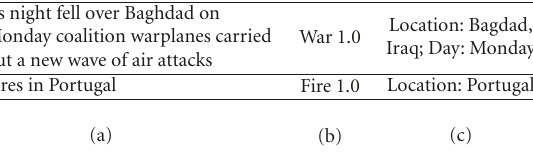
As night fell over Baghdad on Monday coalition warplanes carried